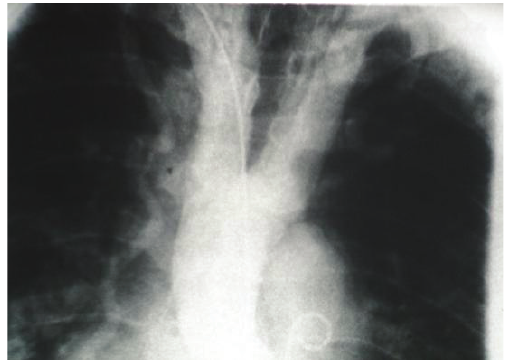
Figure 6: Well-developed collaterals (dilated right internal mam- mary